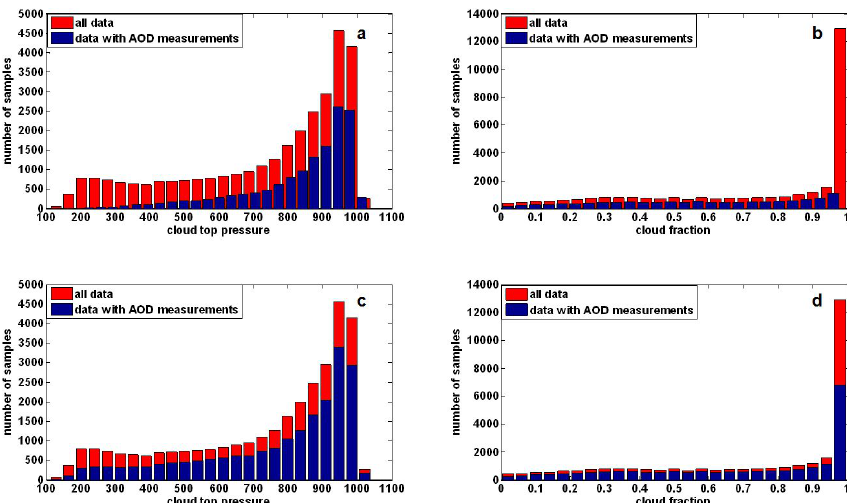
Fig. 7. Histograms of cloud fraction (right) and cloud top height (left) over the Atlantic study area. Red shows all data and blue shows pixels that have both cloud and aerosol information. The upper row shows data used for the analysis using the MODIS AOD without extrapolation (Fig. 3) and the lower row shows data with extrapolation (Fig. 6). It shows how the extrapolation (done only in cases where the adjacent neighbour has a valid AOD retrieval) of overcast pixels adds significantly to increasing the number of high clouds in the analysis (Fig. 7c).